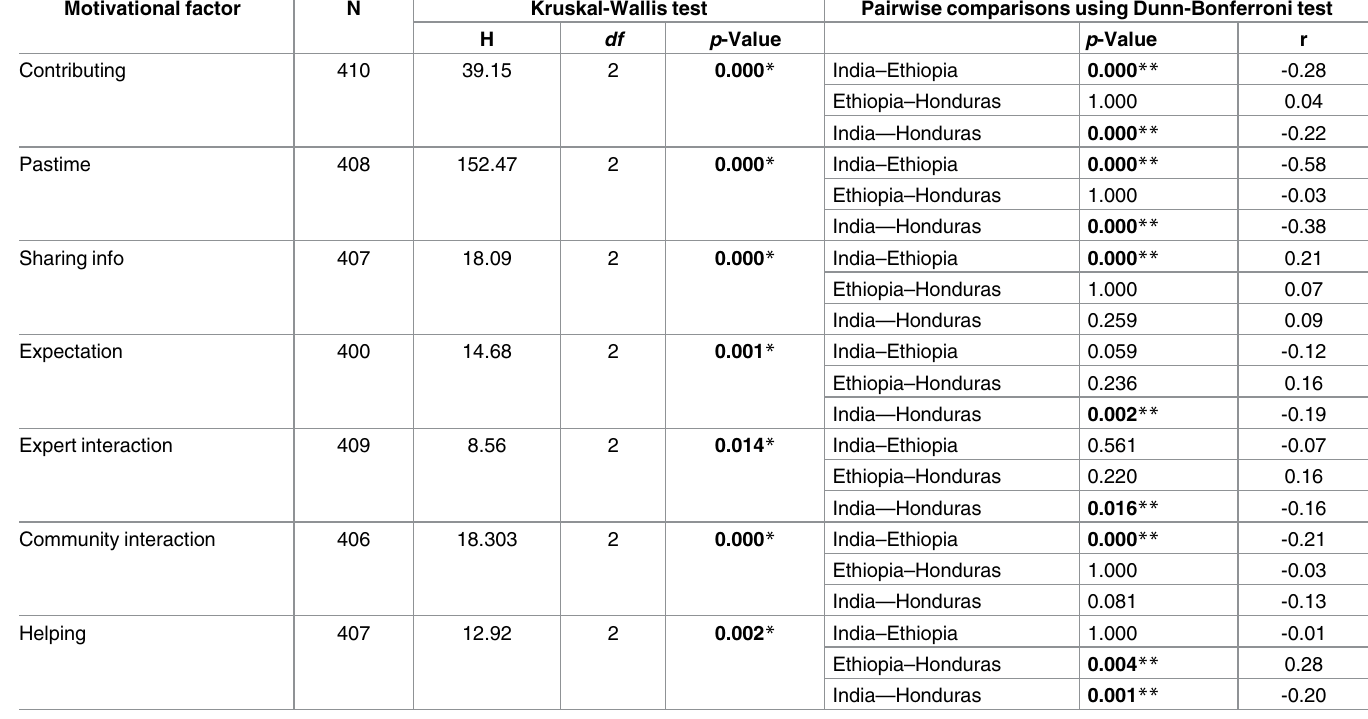
Table 4. Comparisons of motivational factors of farmersbetween the three countries using the Kruskal-Wallis test followed by pairwise compari- sons using the Dunn-Bonferroni test. Motivational factor